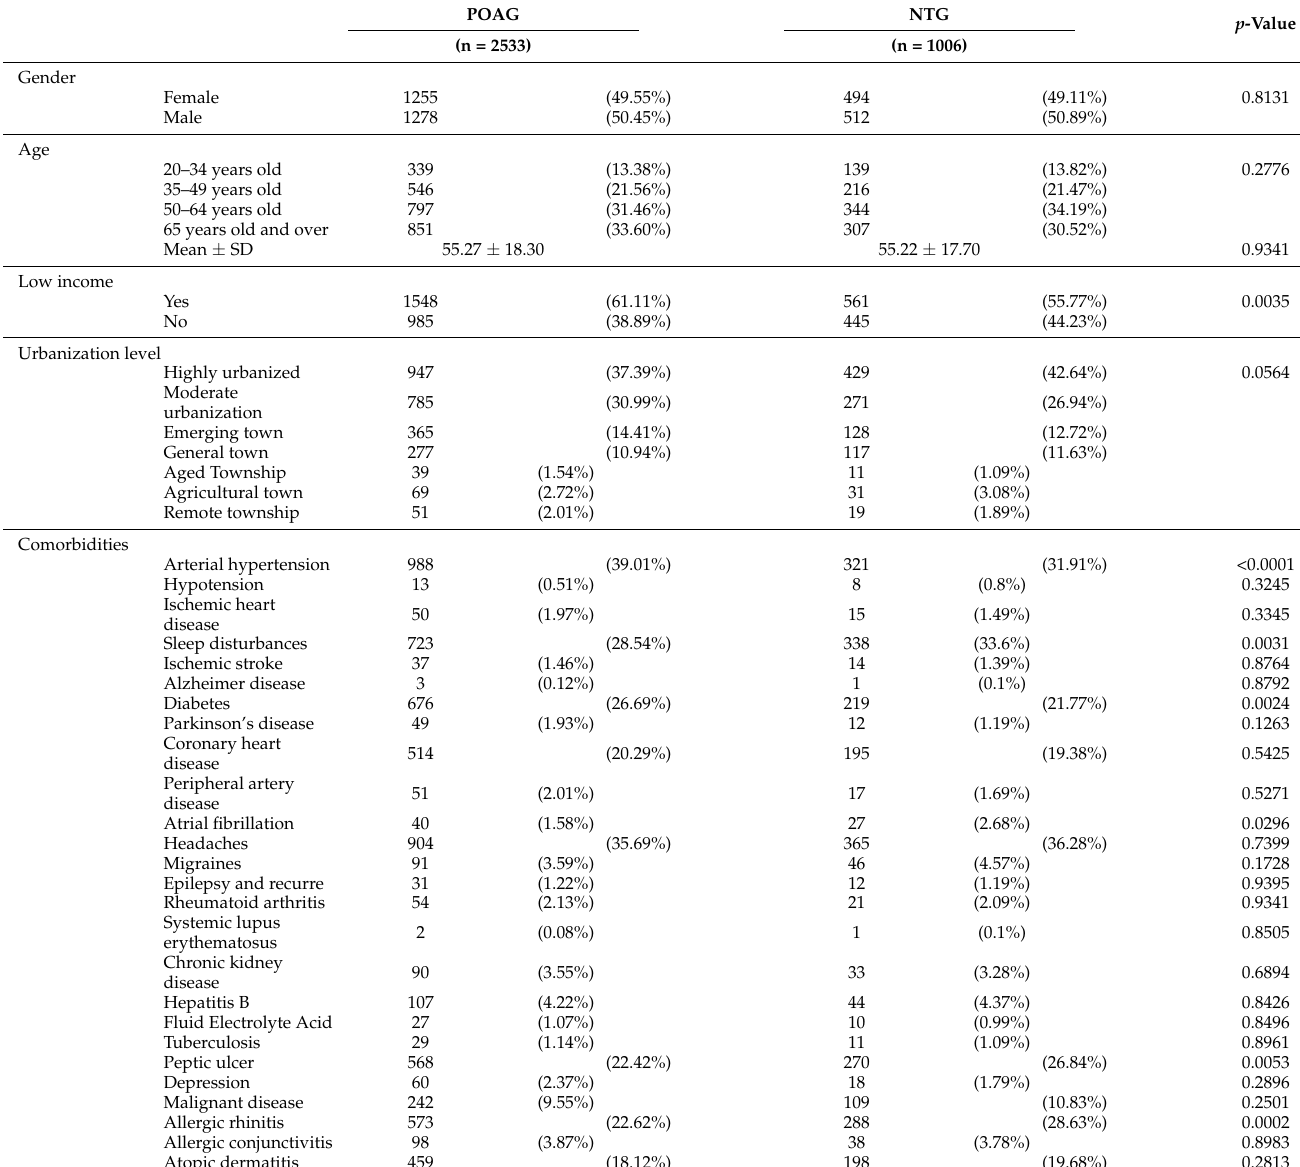
Table 1. Baseline characteristics of participants of POAG and